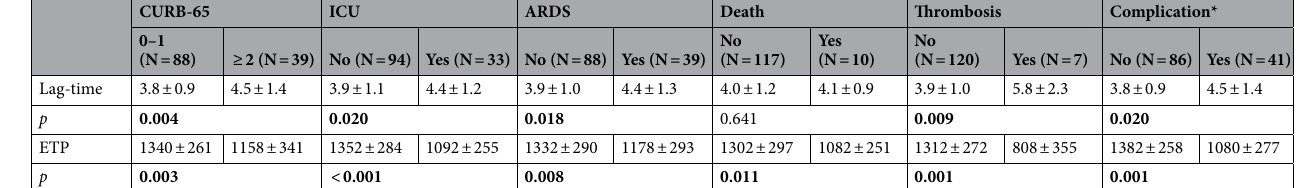
Table 6. Association between clinical outcomes and baseline thrombin generation parameters obtained with tissue factor (5 pM) in samples from hospitalized COVID-19 patients. Bold values denote statistical significance at the p < 0.05 level. ARDS acute respiratory distress syndrome. *Complications include ARDS, Thrombosis, Hemorrhage, or Death. P values were based on Mann–Whitney-U test.